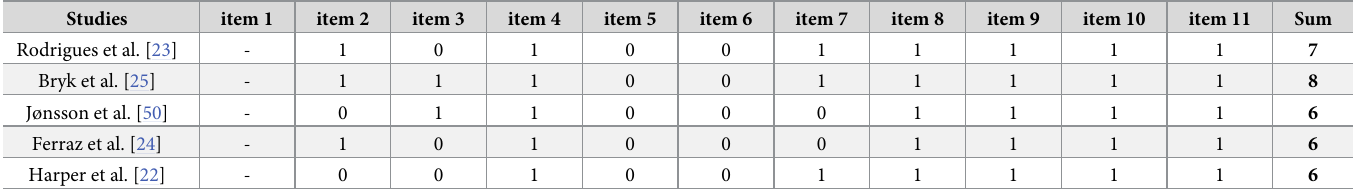
Table 4. Description of quality assessment using the Physiotherapy Evidence Database (PEDro).